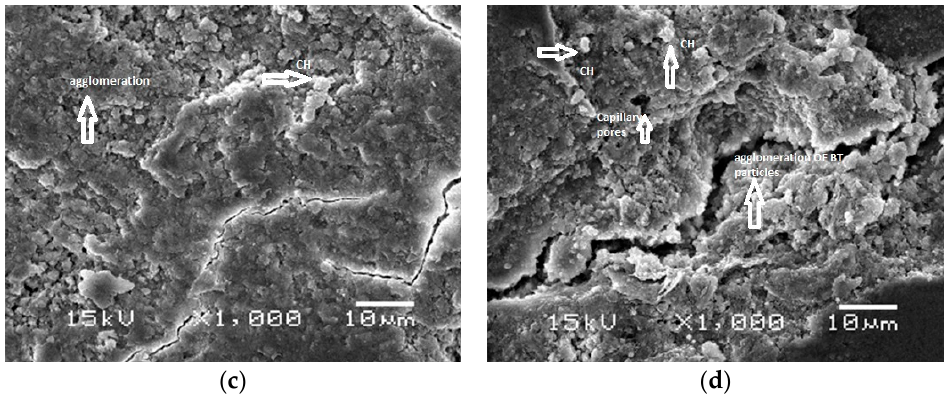
Figure 11. Microstructure of concrete specimens containing FA and BT: ( a ) CC; ( b ) FC; ( c ) BC; ( d ) FBC.